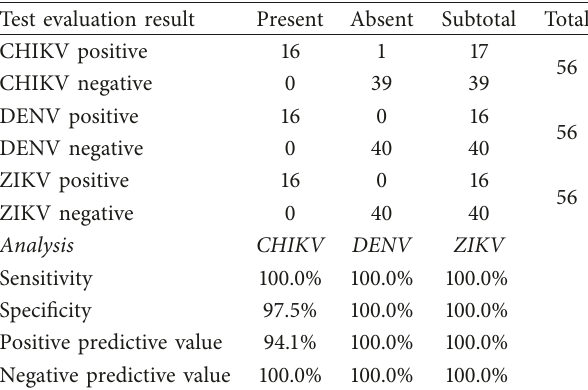
Table 4: rRT-PCR analytical evaluation showing that sensitivity and specificity are effectively 100% for